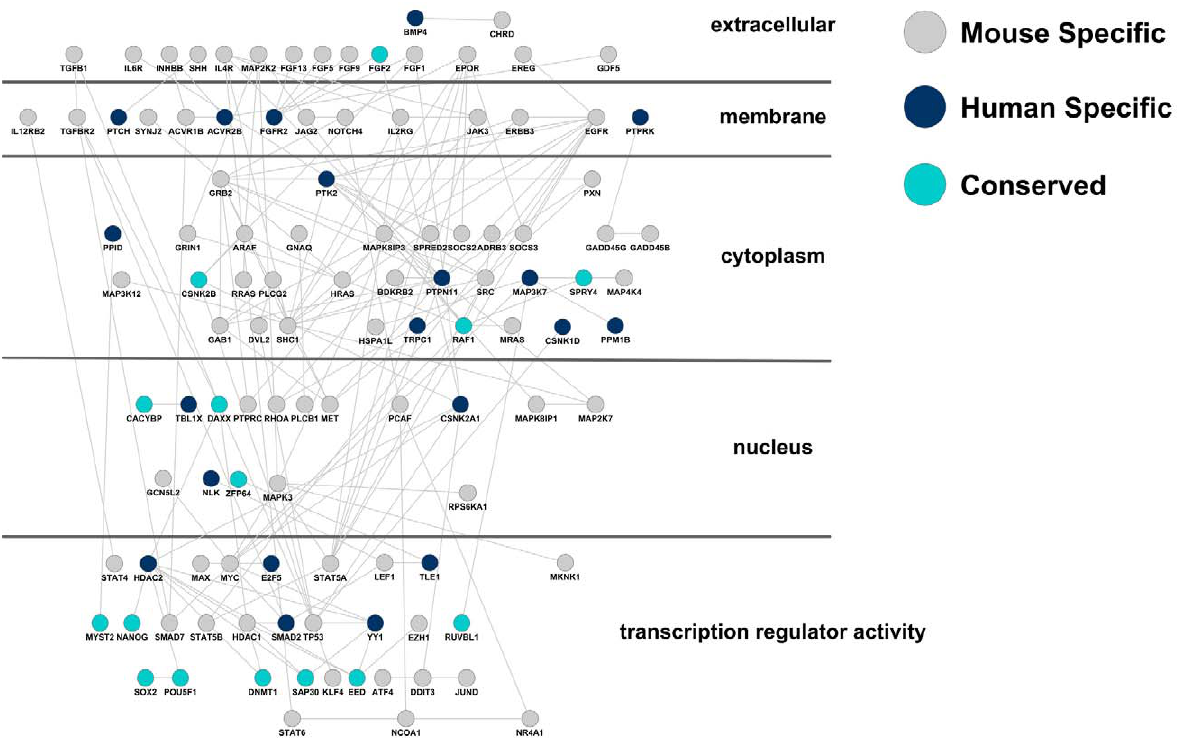
Figure 3. Induced components of signaling pathways in hES and mES cells. The gene induced in either hES or mES cells, i.e., Clusters (2, *), (3, *) and (*, 3), are mapped onto all the signaling pathways documented in the KEGG database [33] and plotted using Cytoscape software (www. cytoscape.org). Gray, blue and green nodes represent genes that are induced in hES cells only, mES cells only or both (conserved), respectively. The edges between any two nodes represent known protein-protein interactions documented in Cytoscape.